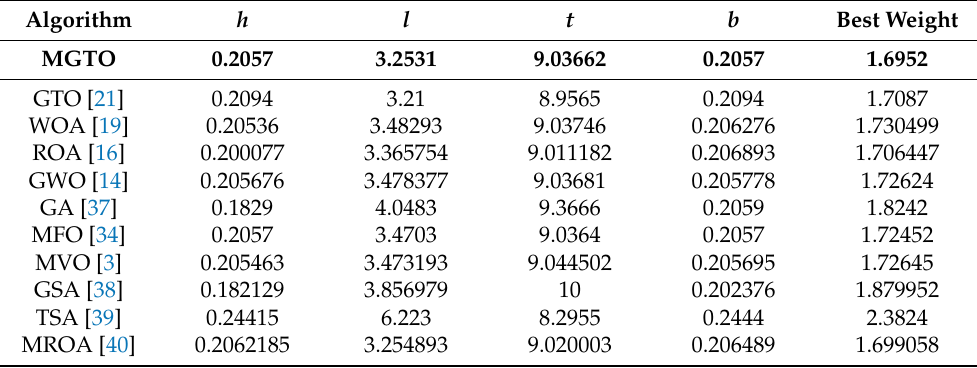
Table 11. Experimental results of the welded beam design problem test.